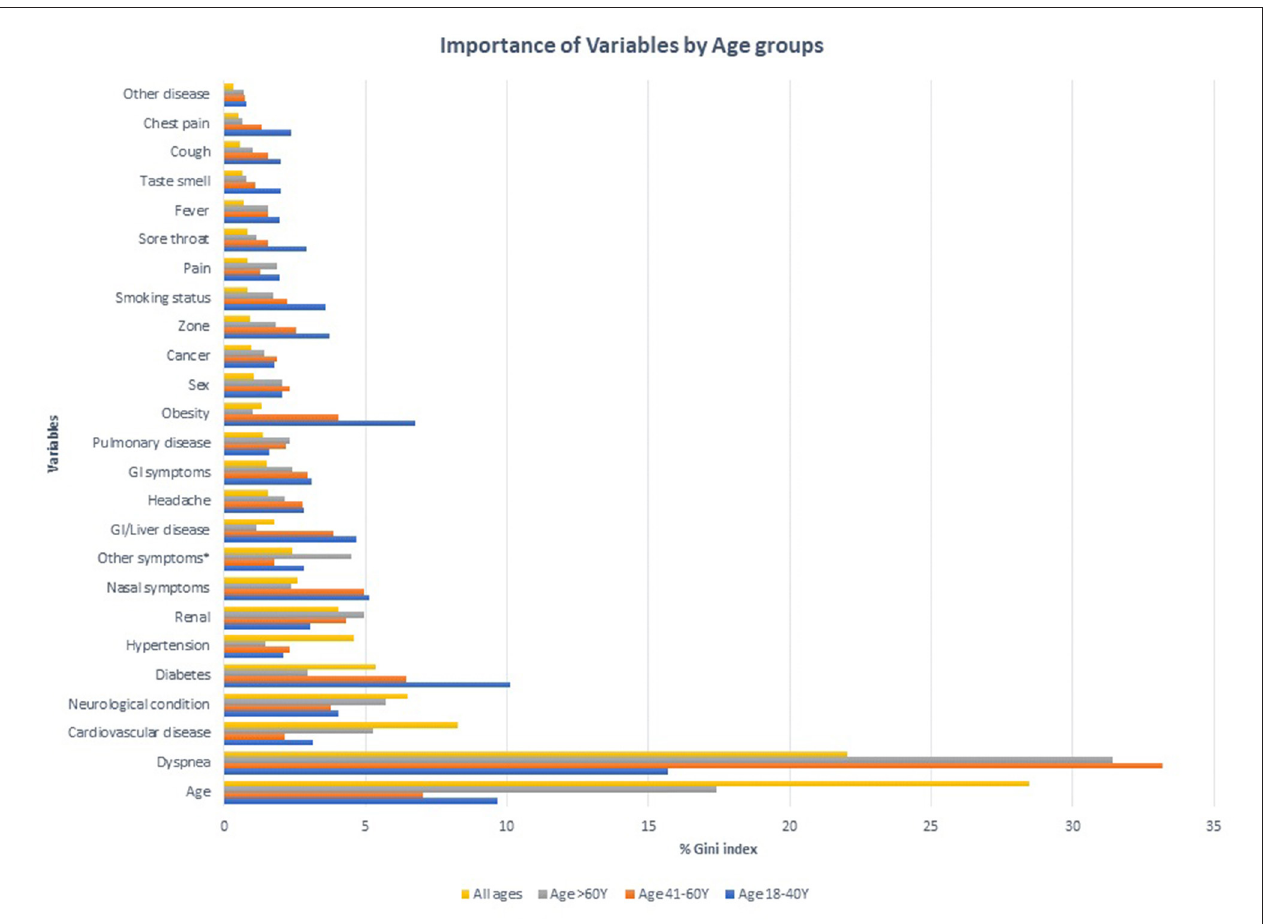
FIGURE 3 | Importance of Variables in predicting severe outcomes among COVID-19 positive cases in different age